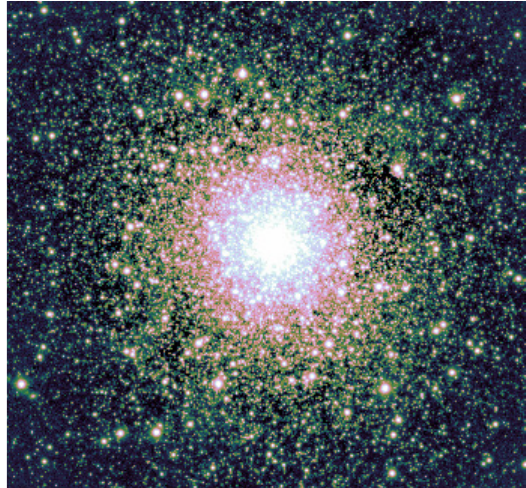
Figure 8. Cut-out image of the globular cluster M92, a visualization of the FITS file mentioned in the text of Section 3 from the Pan-STARRS1 data archive; ≈ 0.2 degrees on each side, which is located on the sky at J2000 equatorial coordinates α = 259.280792 ◦ , δ = + 43.135944 ◦